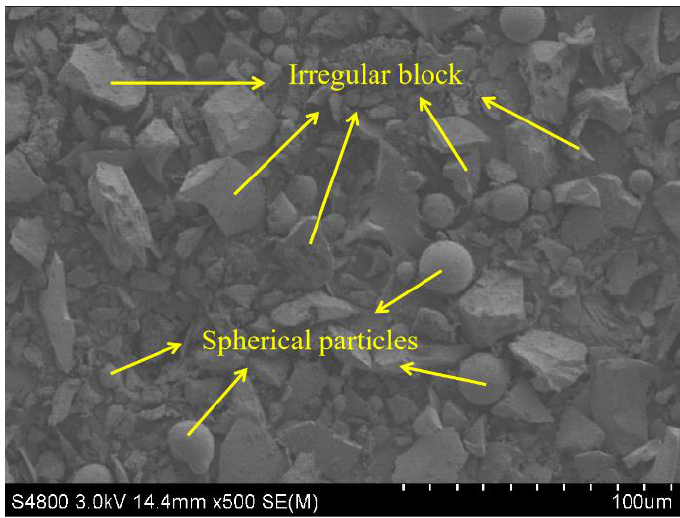
Figure 4. SEM photograph of MCS.